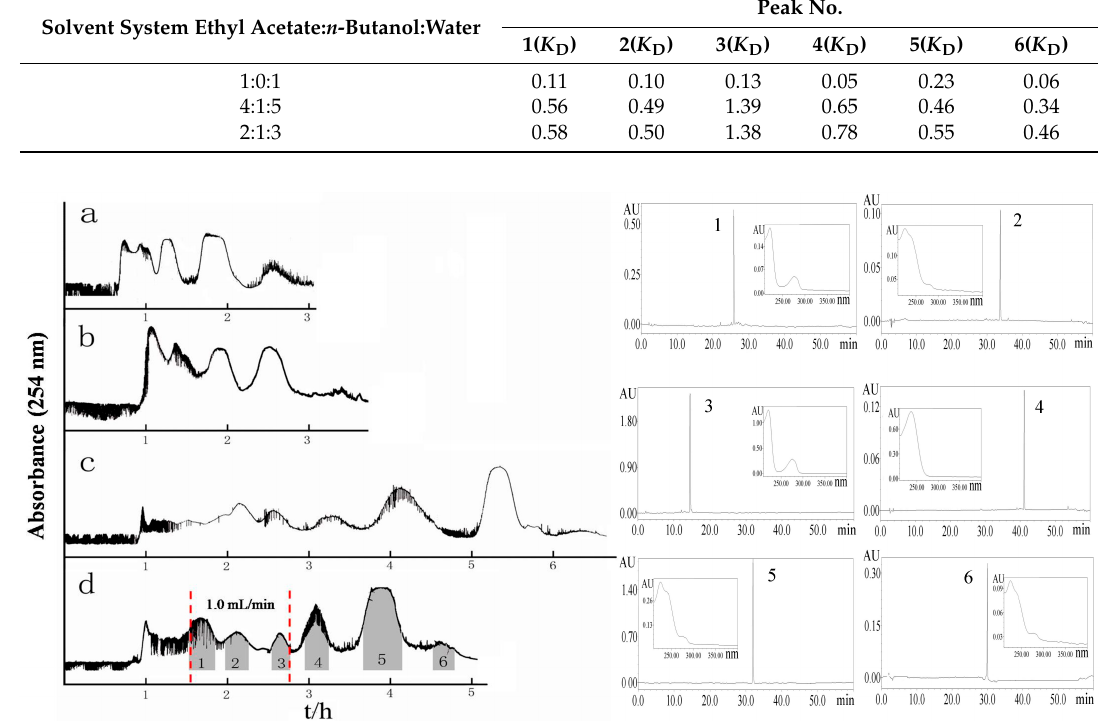
Figure 4. High-speed counter-current chromatography (HSCCC) chromatogram for the separation of Ligustri Lucidi Fructus UPE extract and HPLC analysis of the peak fractions. Experimental conditions: solvent system, ethyl acetate: n -butanol:water (2:1:3, v / v ); the upper organic phase as the stationary phase and the lower aqueous phase as the mobile phase; revolution speed, 800 rpm; flow rate, 0–100